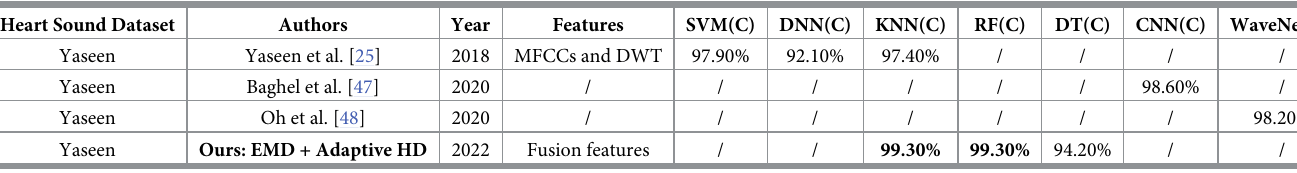
Table 11. Comparison of results using Yaseen